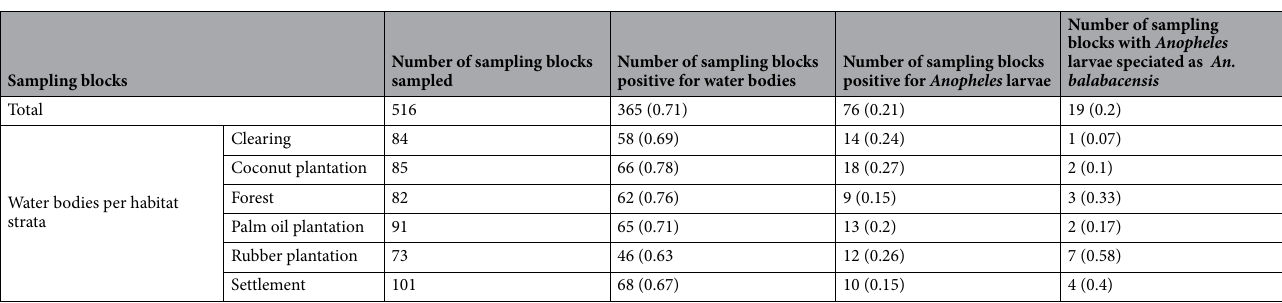
Table 1. Numbers of sampling blocks sampled for water bodies and proportions of these which were positive for Anopheles and An. balabacensis larvae by habitat strata. Proportions included in brackets. Repeated visits to sampling blocks are included in this